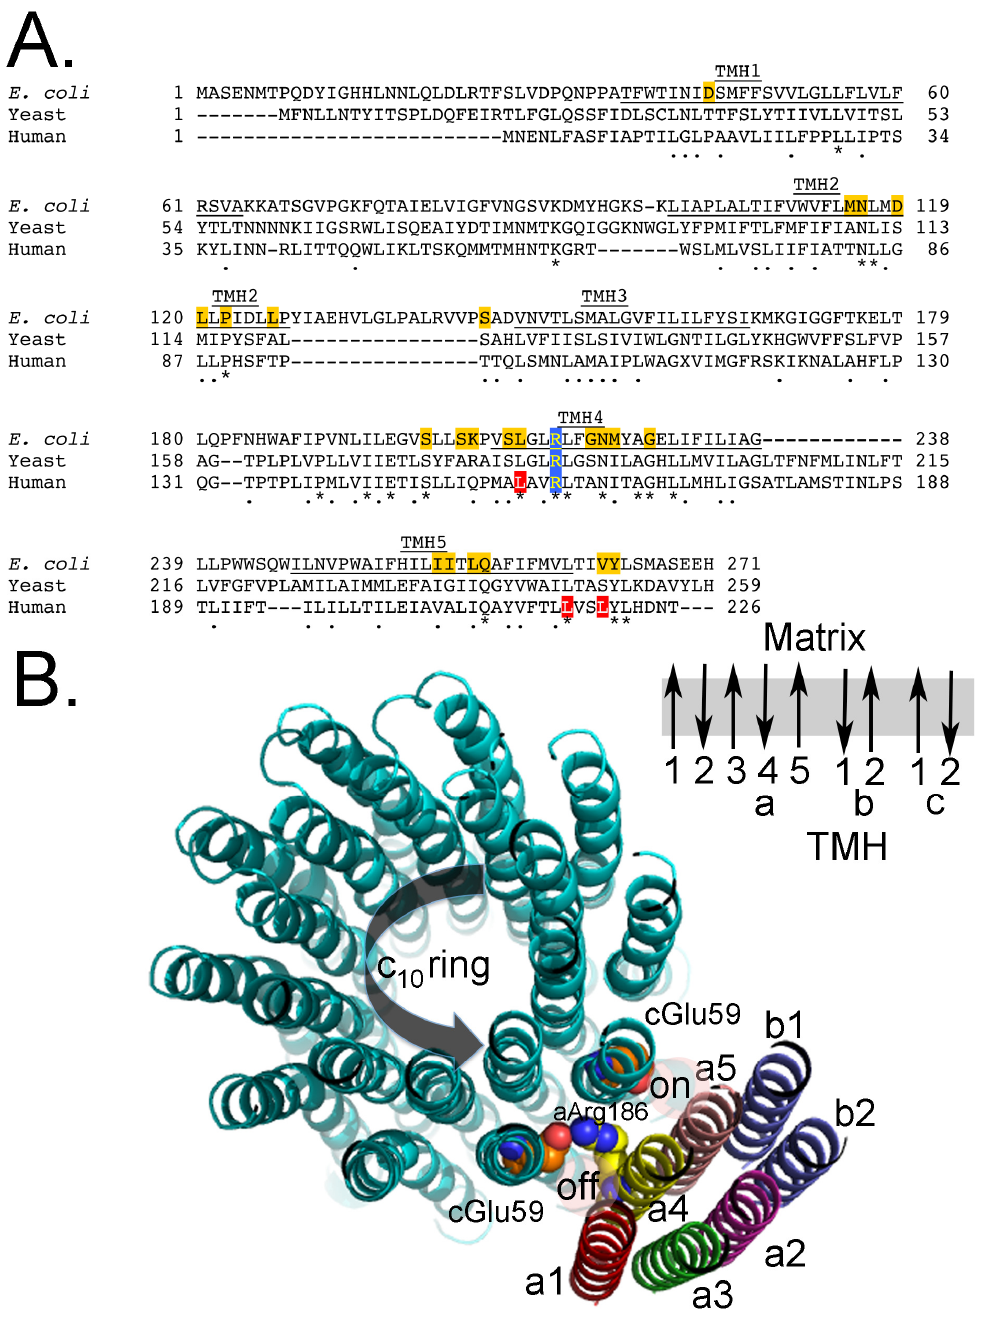
FIGURE 4: Primary sequence alignment of subunit-a. (A) The partial primary sequence alignment of subunit-a from E. coli , yeast, and hu- man is shown. The residues predicted to form transmembrane helices 3-5 (TMH3-5) are underlined and labeled [54, 56, 63, 145]. The highly conserved and essential R210 ( E. coli numbering) is shaded blue. The residues shaded red are mutated in the discussed human diseases. The residues shaded gold are identified as important for proton movement [54, 204]. (B) Hypothetical model of the arrangement of the helices from subunits a, b, and c. The helices from subunits a (5 helices), b (2 helices) and c (20 helices) are shown along with the side chains for a- Arg1876 (yellow/blue) and c-Glu59 (red). There is very little cross-linking data positioning Helix 1 of subunit-a and thus the position is in- ferred from the absence, rather than presence, of cross-linking. Subunit b is thought to have a stoichiometry of 2 in the E. coli enzyme and 1 in the mitochondrial enzyme and there is 1 transmembrane helix in the bacterial subunit and 2 in the mitochondrial subunit. This view is from the matrix side of the mitochondrion. Also shown is the relative direction for deportation/protonation of c-Glu59 during ATP synthesis. The black arrow indicates the direction of rotation during ATP synthesis. Also shown is a schematic of the orientation of the transmembrane helices (TMH) for subunits a, b, and c in the membrane. Note that the helices for the subunits-a and -b are representations of a possible placement and secondary structure, while the structure of the c-ring is a crystal structure obtained from yeast